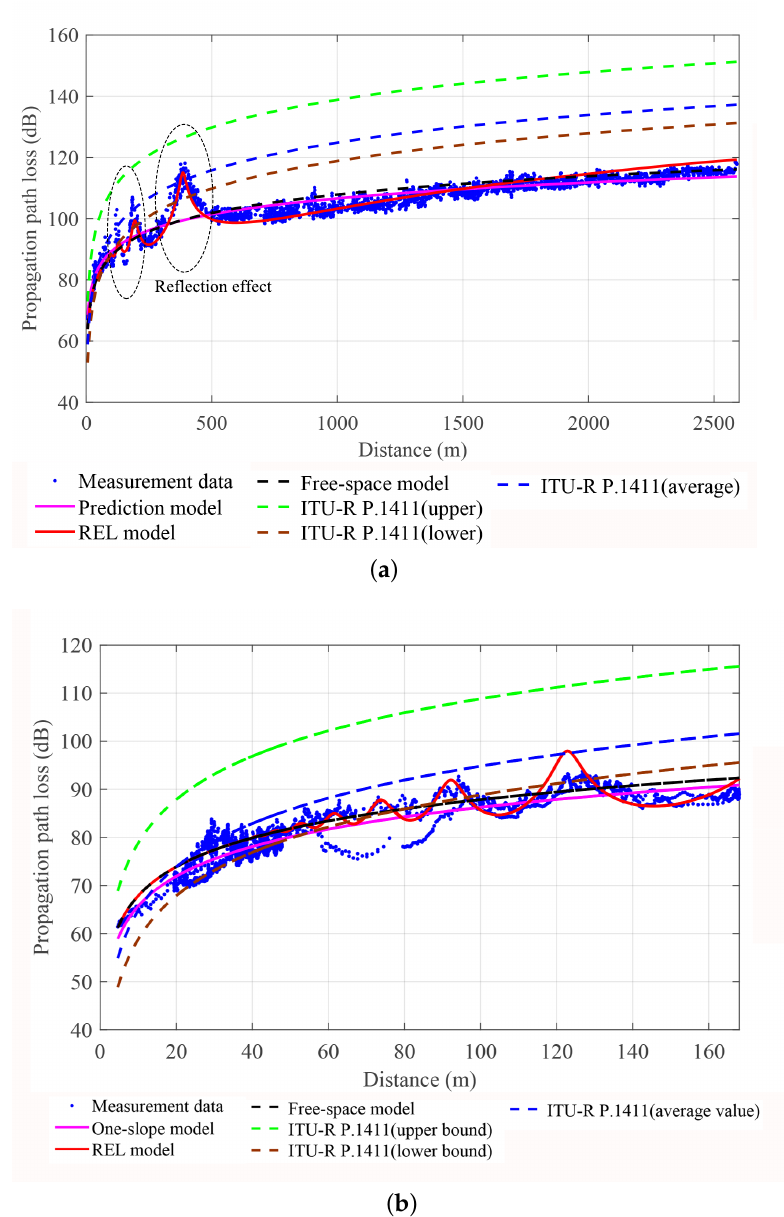
Figure 6. Propagation path loss. ( a ) S2I measurement, ( b ) S2S